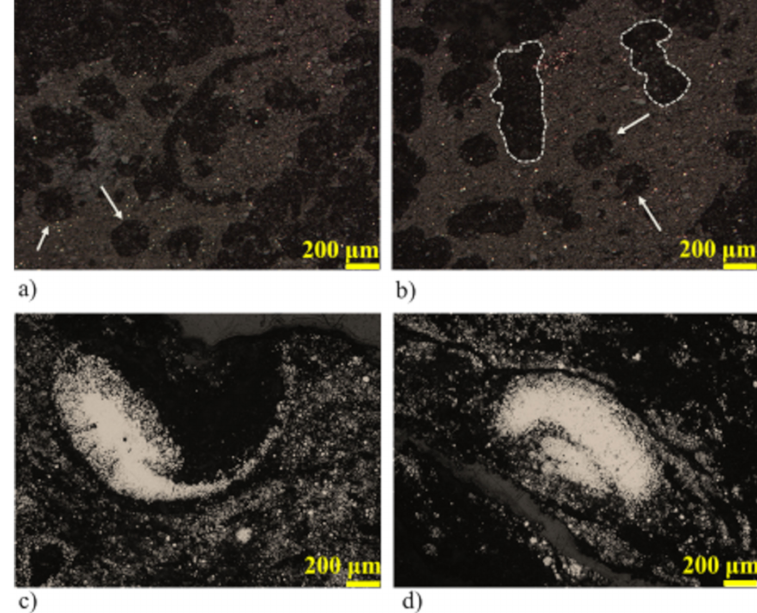
Figure 6. Photomicrographs under reflected light; ( a , b ) microbial structures (lenticular, spherical, and stromatolitic); ( c ) pyrite infilling structures; ( d ) lensoidal pyrite